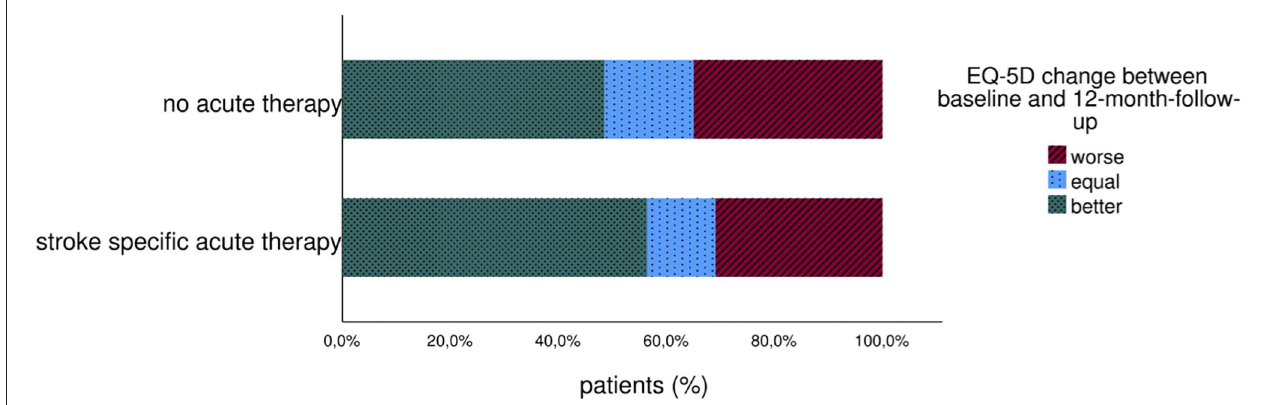
FIGURE 2 | Change of long-term patient-reported overall health (EQ VAS) of stroke patients with and without acute therapy.